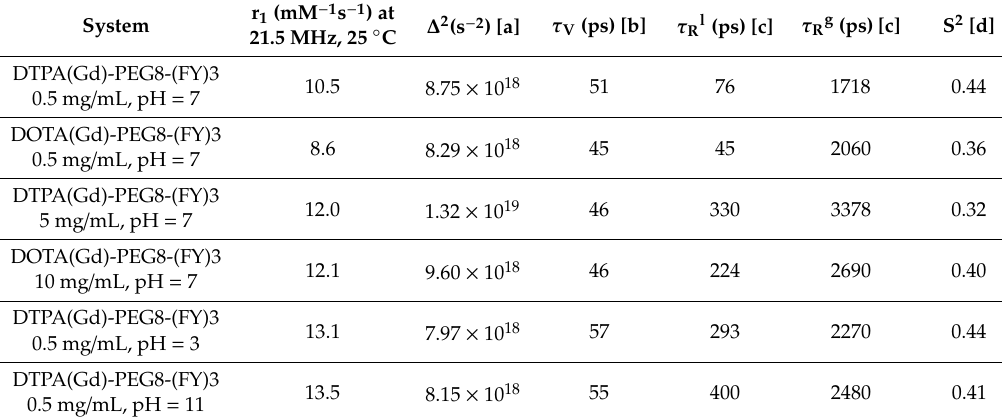
Figure 5. ( a ) Longitudinal proton relaxivity of DTPA(Gd)-PEG8-(FY)3 and DOTA(Gd)-PEG8-(FY)3 measured at 21.5 MHz (0.5 T) and pH = 7 as a function of temperature. ( b ) Longitudinal proton relaxivity of DTPA(Gd)-PEG8-(FY)3 and DOTA(Gd)-PEG8-(FY)3 measured at 21.5 MHz (0.5 T) and 298 K as a function of pH of the solution. ( c ) Nuclear magnetic resonance dispersion (NMRD) profiles of aqueous solutions of Gd-DTPA-PEG8-(FY)3 (0.5 mg / mL) at 298 K and pH = 3 and pH = 11. The data refer to 1 mM concentration of the paramagnetic complexes. Table 1. Main relaxometric parameters derived from fitting of NMRD profiles reported in Figures 4 and